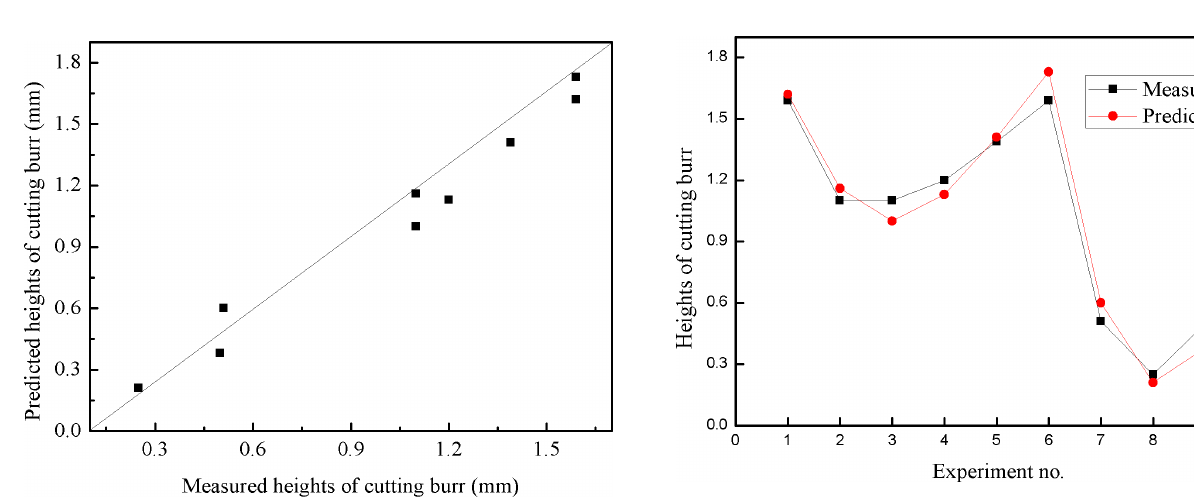
Figure 12. Scatter diagram of measured tool life and predicted tool life for the testing data set.